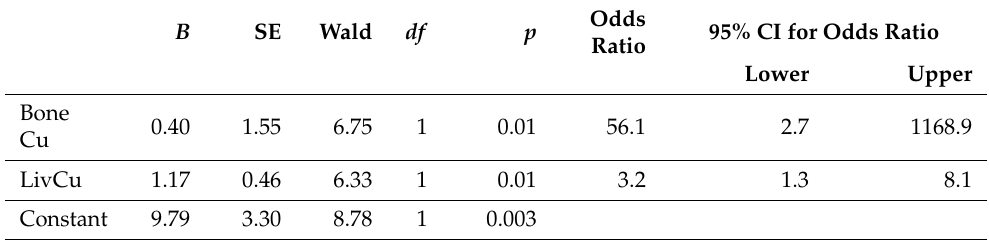
Table 2. Results of the logistic regression test for predicting humeral fracture in cows based on liver and bone Cu concentration; B : B coefficient for the constant; SE: standard error; Wald: Wald chi-square